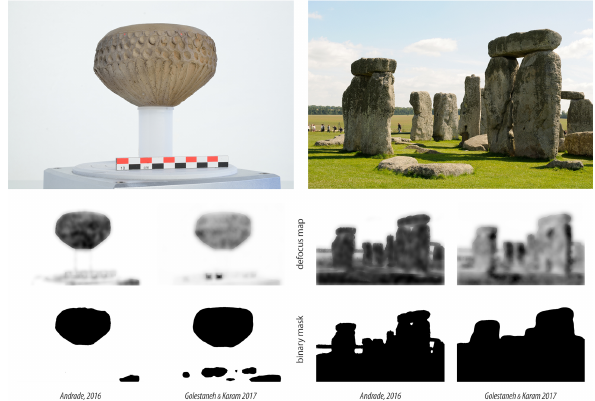
Figure 7. Defocus map estimation of two different images using an edge-based and a recent patch-based